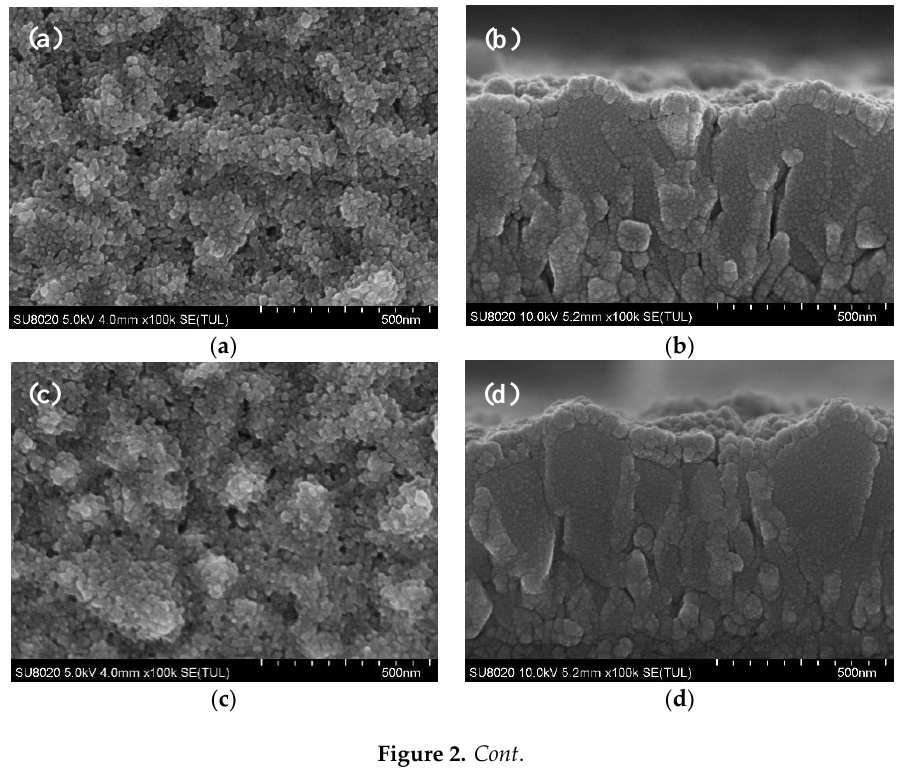
Figure 1. Transmission electron microscope (TEM) images of TiO 2 nanoparticles: ( a ) The low magnification; ( b ) The high